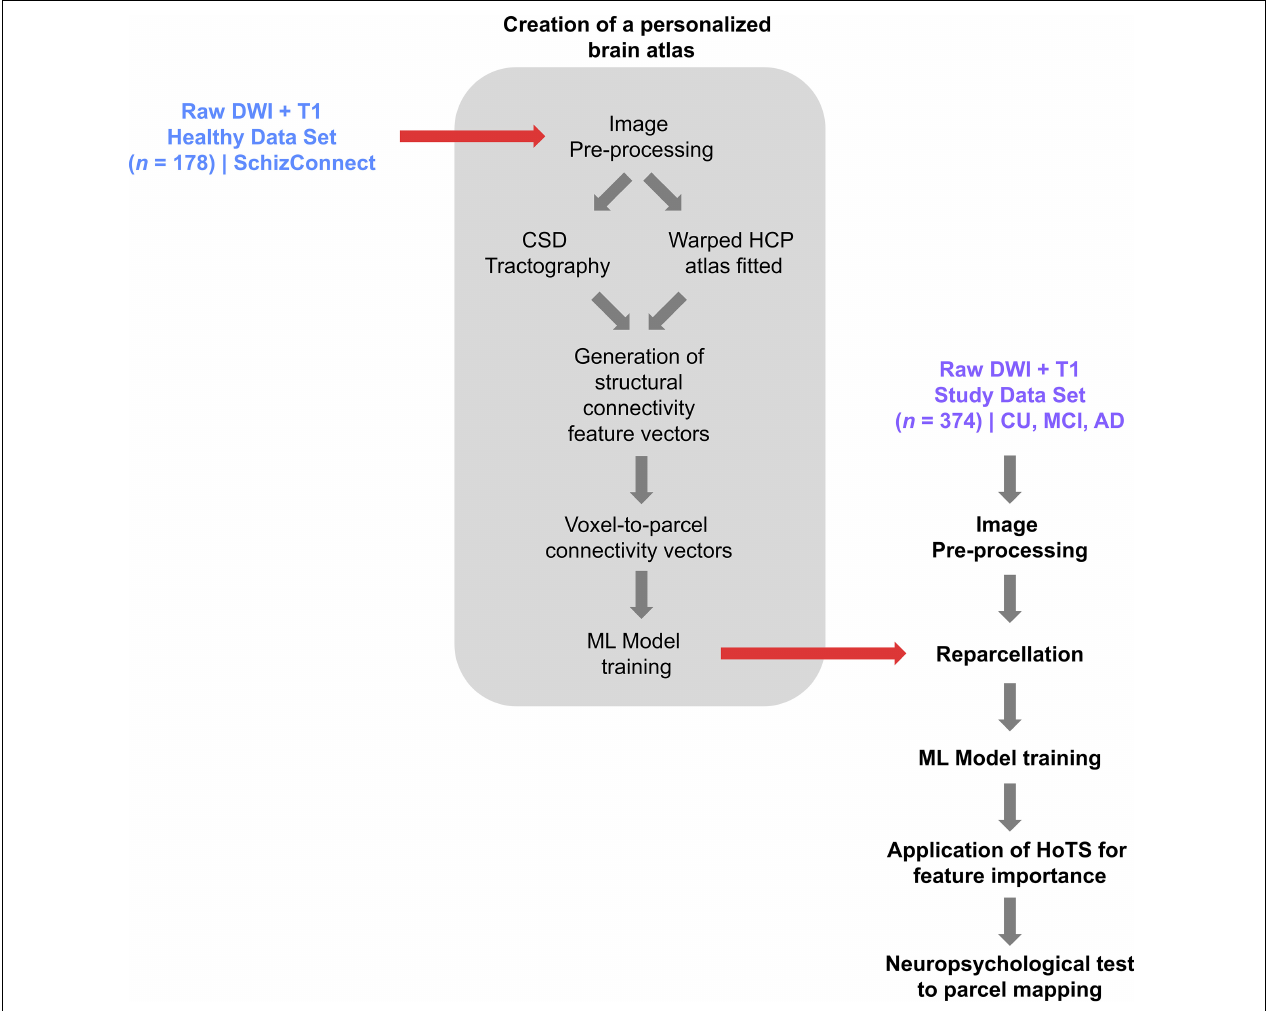
FIGURE 1 | A flowchart demonstrating the process of creating a personalized atlas for each individual in the study sample, referred to as